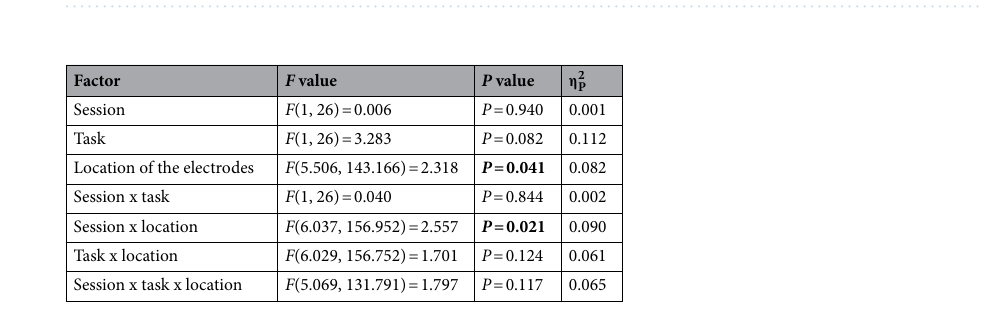
Table 5. The results of repeated measures ANOVA for ERP latency parameter. Significants are in